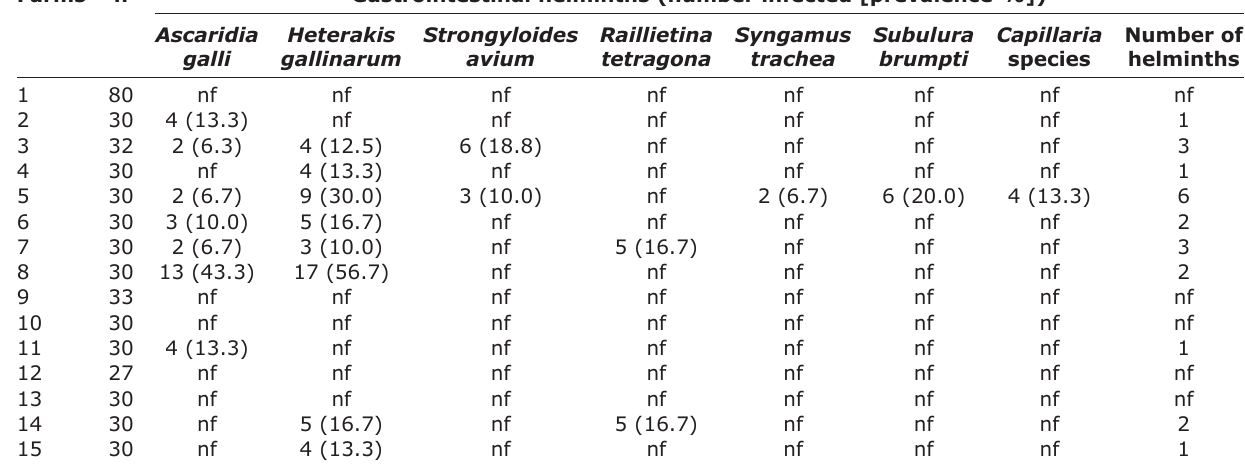
Table-2: The prevalence (%) of gastrointestinal helminth parasites from the different poultry farms in Kwara Central, Kwara State. Farms n